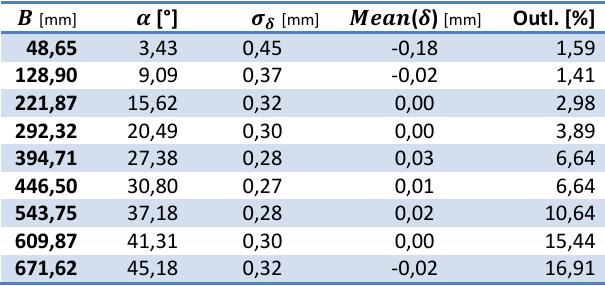
Table 2: Differences of the point cloud from 9 single stereo models to the reference surface in ray direction. Baseline, intersection angle, std. deviation of difference, mean of difference, amount of